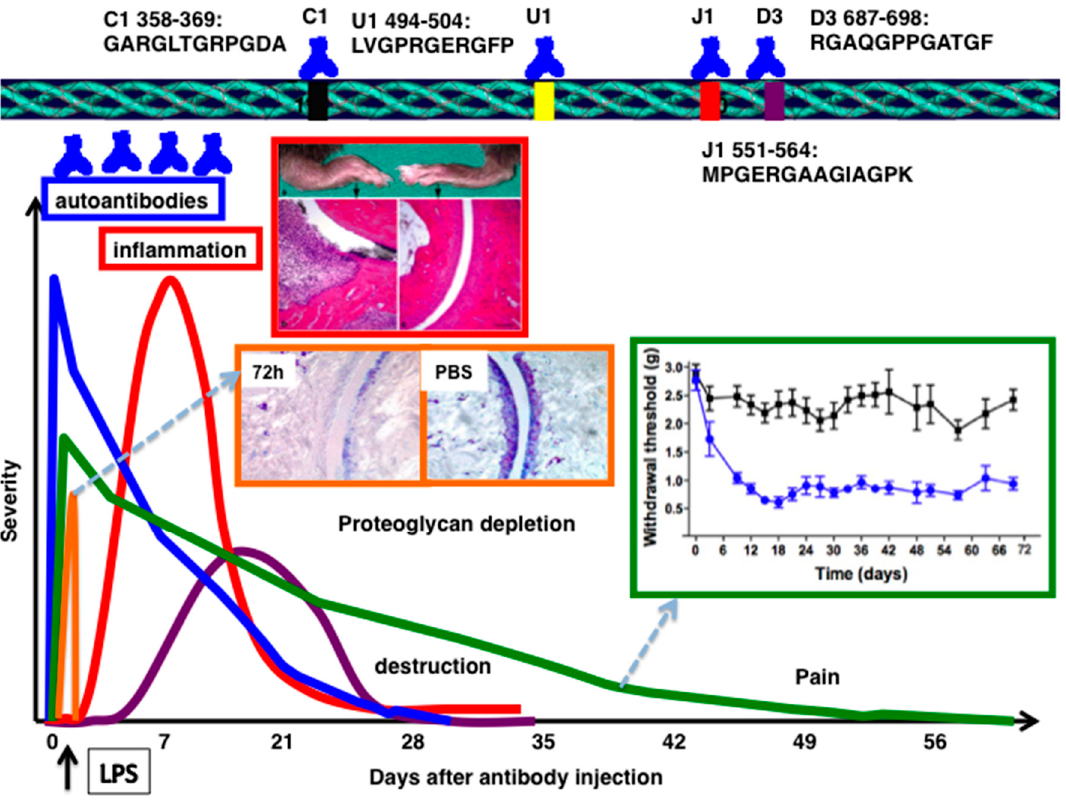
Figure 1. Schematic diagram of acute form of collagen antibody induced arthritis. Autoantibodies binding to well defined epitopes are transferred at day 0, followed by injection of lipopolysaccharide from E. coli 05:B55 as the secondary stimulus at day 3. Significant level of proteoglycan depletion was observed 72 h after antibody injection. Inflammation (red and swollenness) and, cartilage and bone erosions between arthritis and control mouse are shown. HE stained joint morphology of arthritis and control mice. Magnification, 10 × . Pain (withdrawal threshold levels) started even before inflammation began and prolonged even after resolution of inflammation. Dotted arrows indicate the inserted figures.